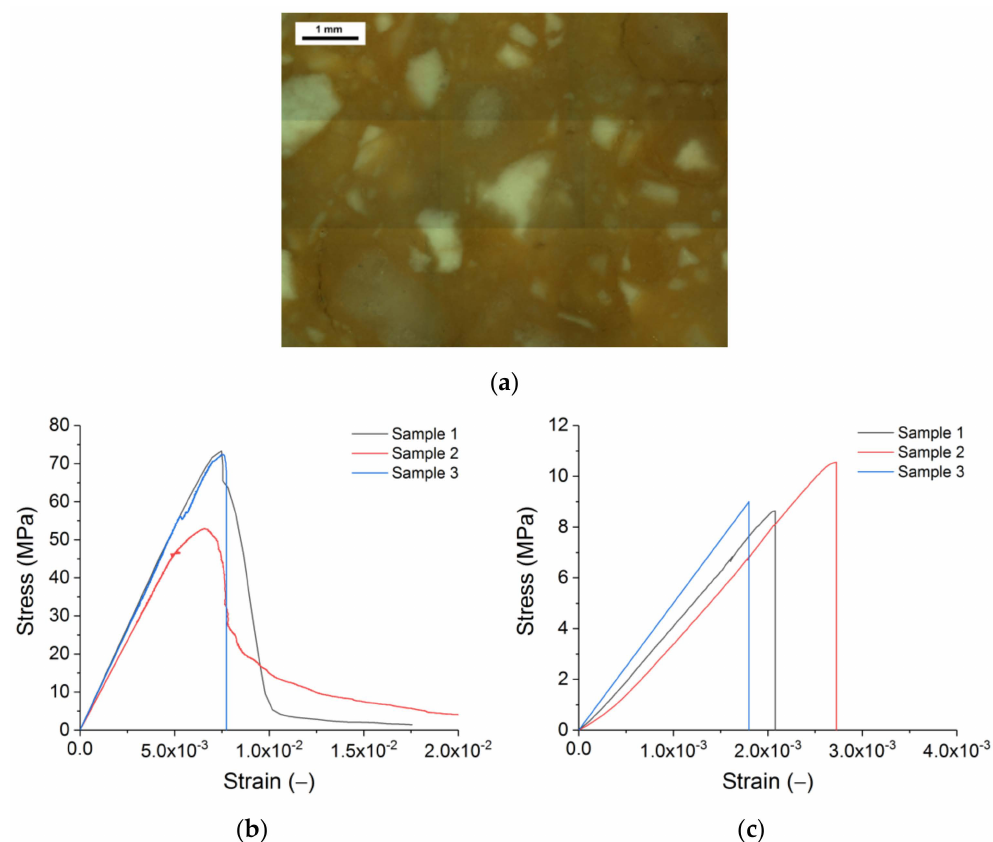
Figure 1. A typical microstructure of silica refractories as seen in light optical microscopy conducted in cross-parallel light ( a ), and experimentally obtained diagrams of a uniaxial compression test ( b ) and a three-point bending test ( c